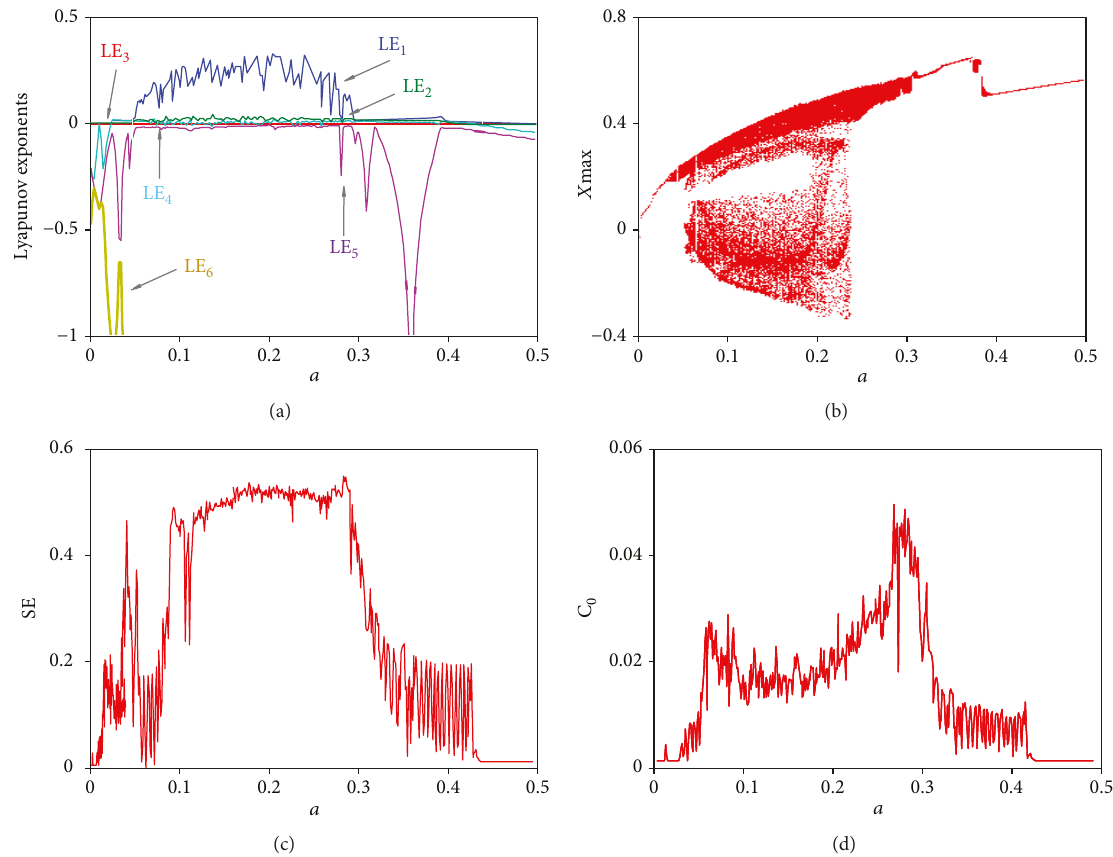
Figure 6: Dynamical analysis with di ff erent circuit parameter a . (a) Lyapunov exponent spectrum, (b) bifurcation diagram, (c) SE complexity, and (d) C complexity. 0